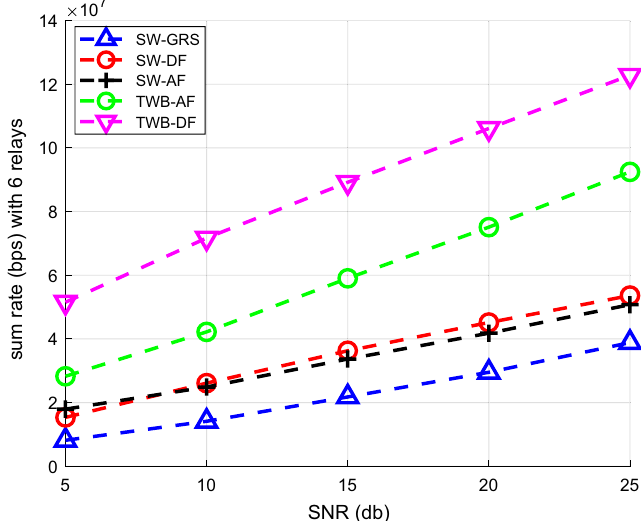
Fig. 8 Sum-rate curves among schemes. It is the sum-rate curve with 6 relays, and the transmit SNR is 5–25 db, including SW-GRS, SW-AF, SW-DF, TWB-AF and